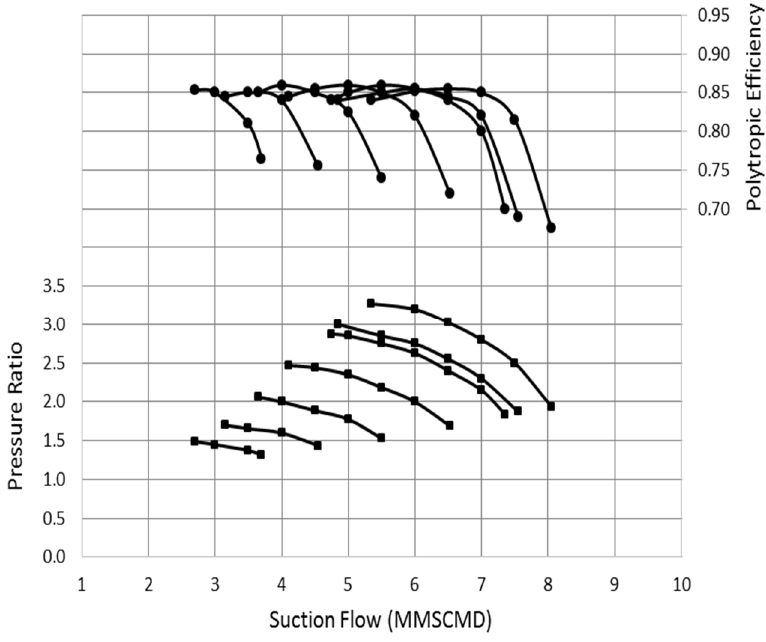
Figure 3. Derived performance curve based on measured discharge pressure and